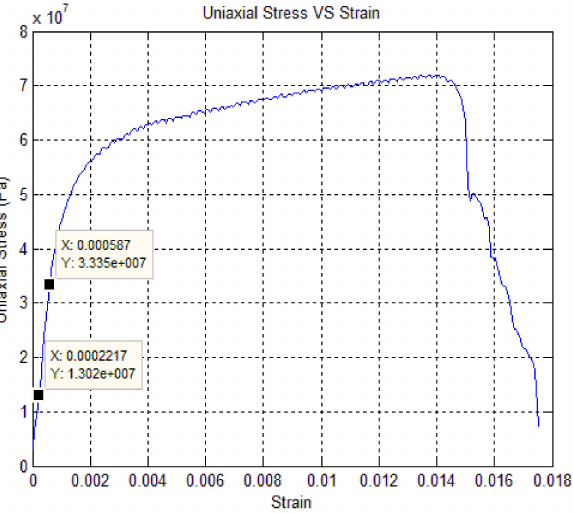
Figure 11. Stress vs. strain graph.